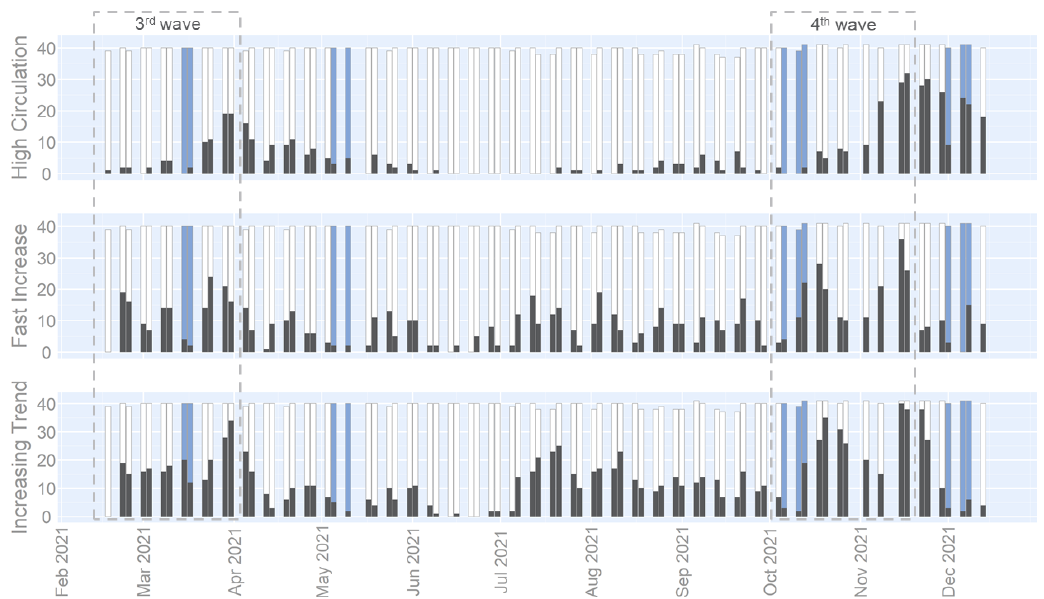
Figure 2. Evolution of the number of areas for which the wastewater indicators are positives. The indicators are computed on the viral concentration (SARS ‐ CoV ‐ 2 RNA gene copies/mL) with the 3rd wave as reference period (15/02/2021–01/04/2021): High Circulation, Fast Increase, and Increas ‐ ing Trend. The number of areas for which each indicator is positive or not is indicated by black and white bars, respectively. Wastewater samples impacted by the rain are marked with blue bars. Total number may be lower than 42 when technical issues prevented samples to be taken for some of the wastewater treatment plants.